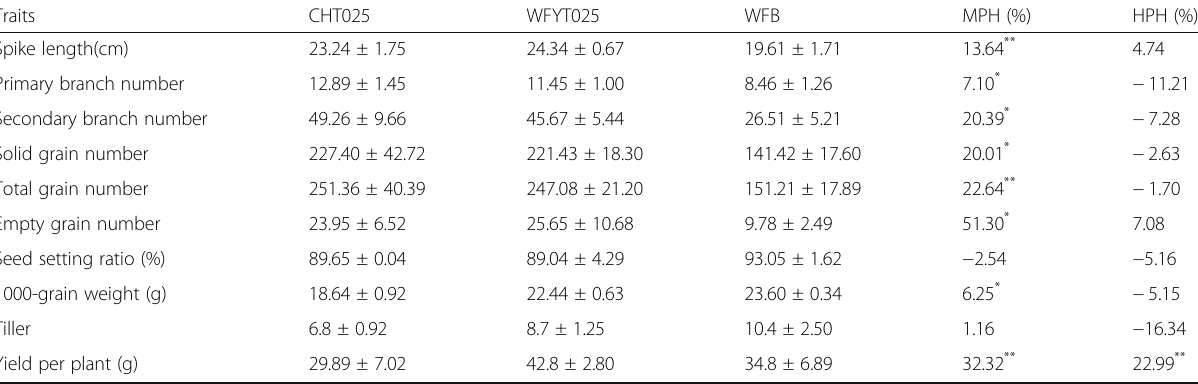
Table 1 Phenotypic Analysis of Super Hybrid WFYT025 Combination